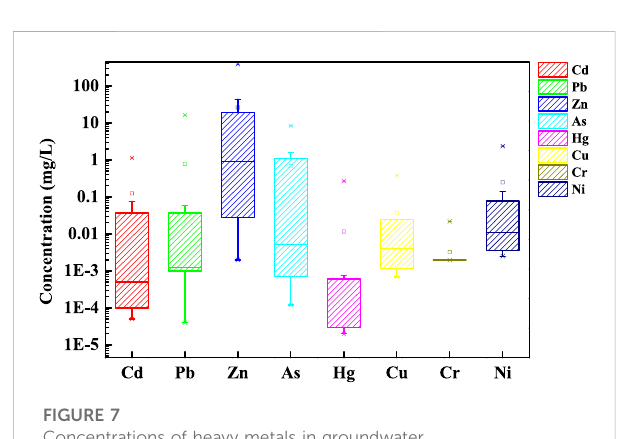
FIGURE 7 Concentrations of heavy metals in